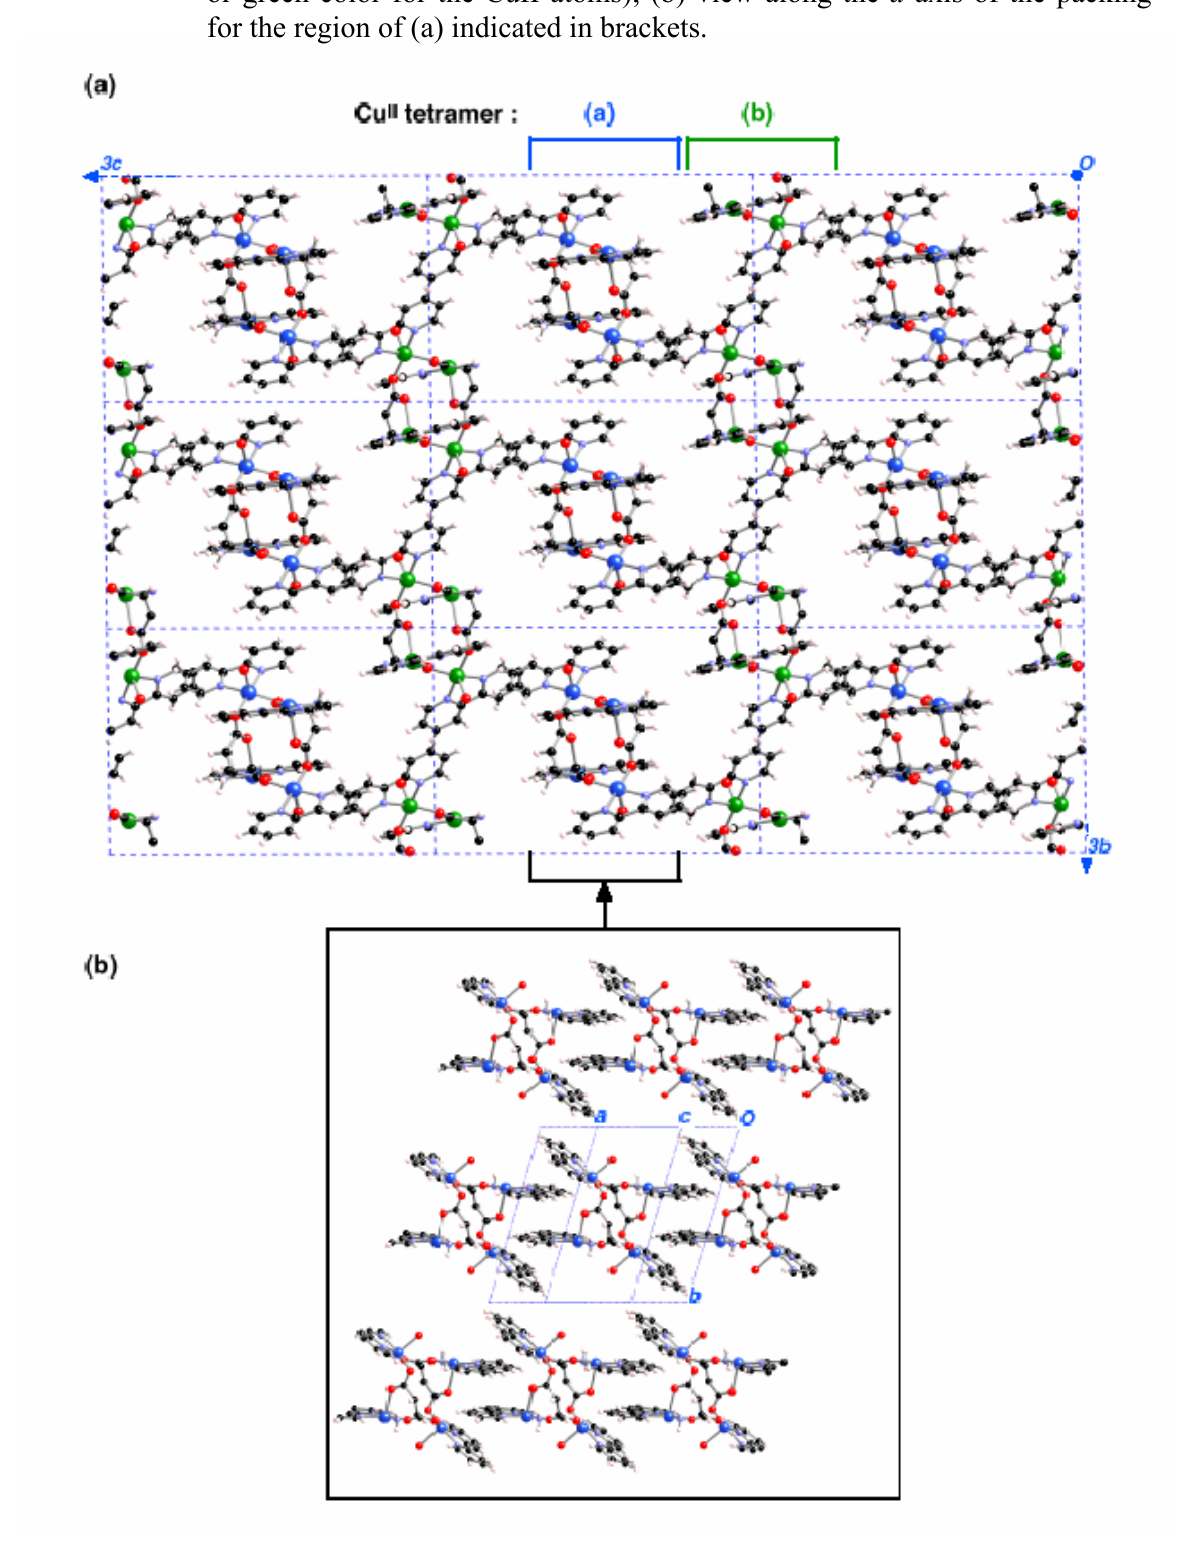
Figure 3 . Packing of the [Cu of the bc plane (the two non-equivalent tetramers are identified by using blue or green color for the CuII atoms); (b) view along the a -axis of the packing for the region of (a) indicated in